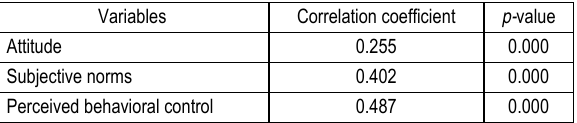
Table 2. Correlations (EE versus the antecedents of